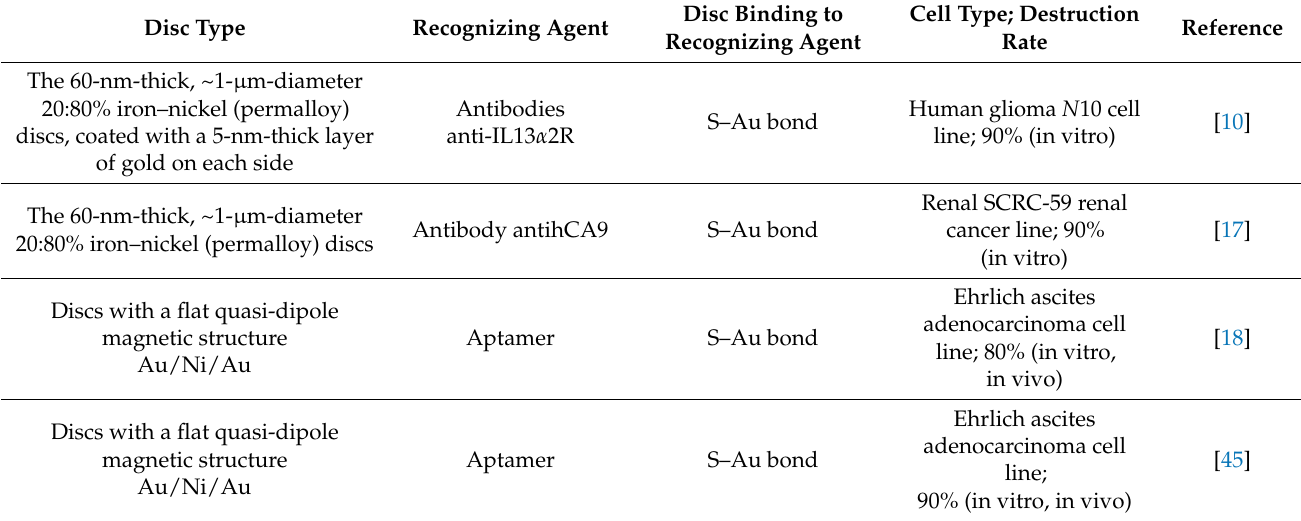
Table 2. The biological effects of magnetic discs functionalized with antibodies and